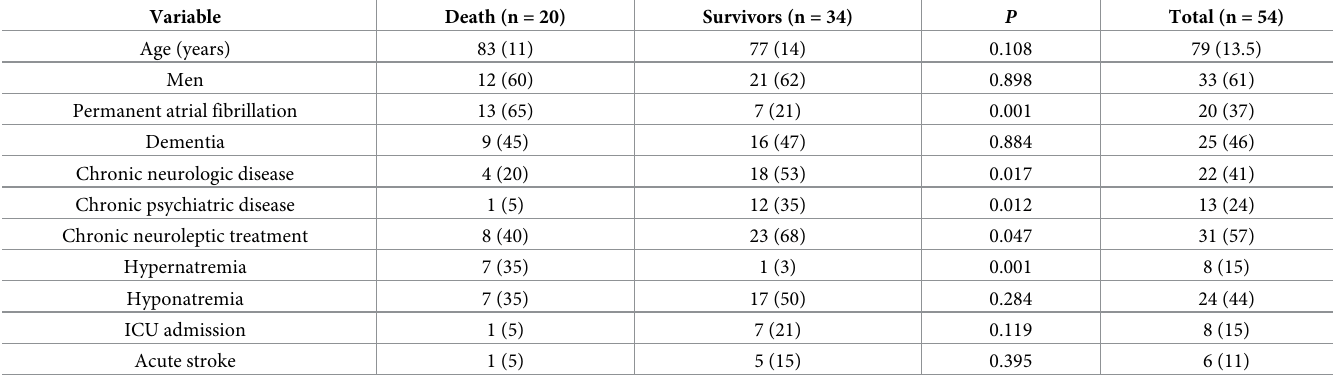
Table 2. Variables linked to